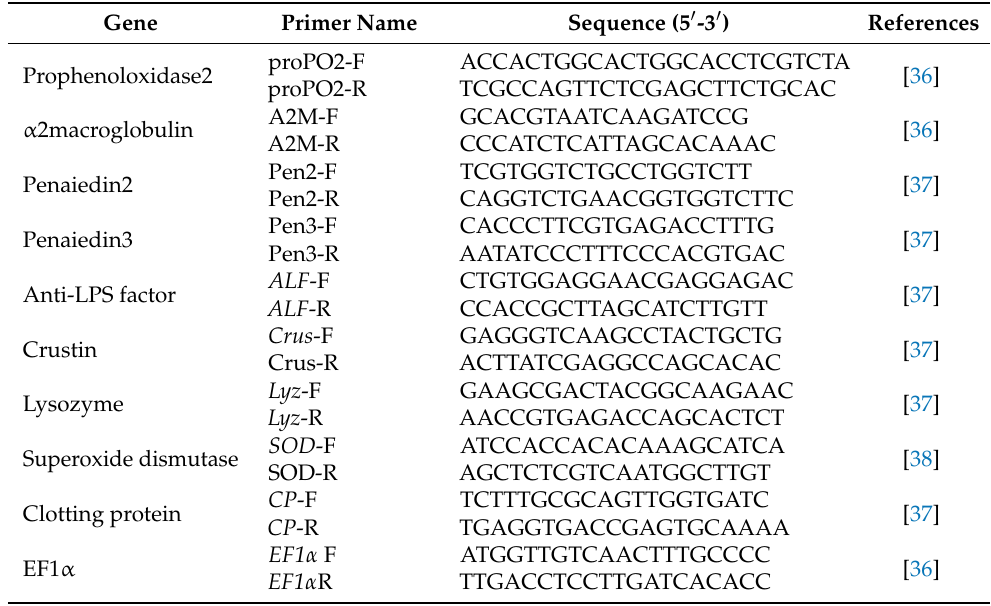
Table 2. Primers of immune-related